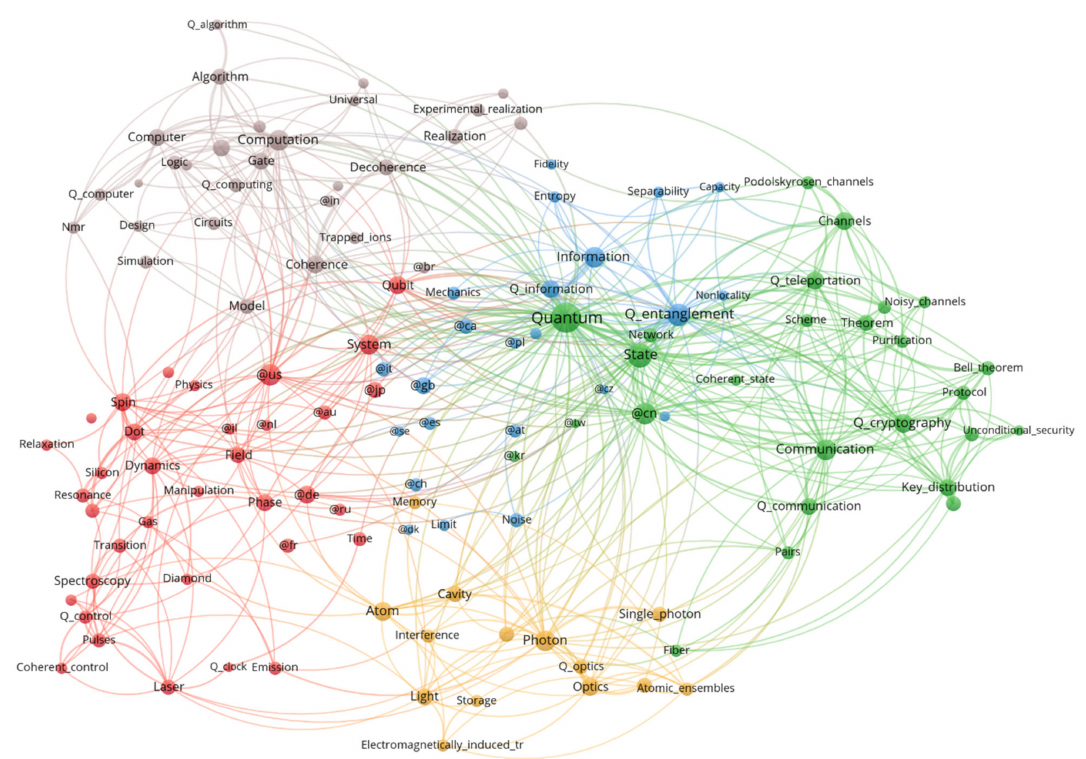
Figure 9. Co-occurrence map of (1) the top 25 countries of Table 3 (denoted by their two-letter country code with a prefixed “@”) with at least 400 occurrences and (2) the top 104 keywords (author keywords and keywords plus) with at least 300 occurrences in the total publication set from 1980 to 2018. The map shows five topical clusters, using the VOSviewer parameters resolution = 1.1 and minimal cluster size = 5. For better readability, in compound keywords the term quantum is abbreviated to Q. An online version is provided at https://s.gwdg.de/IULOc3 (accessed on 1 August 2021) (cluster colors probably